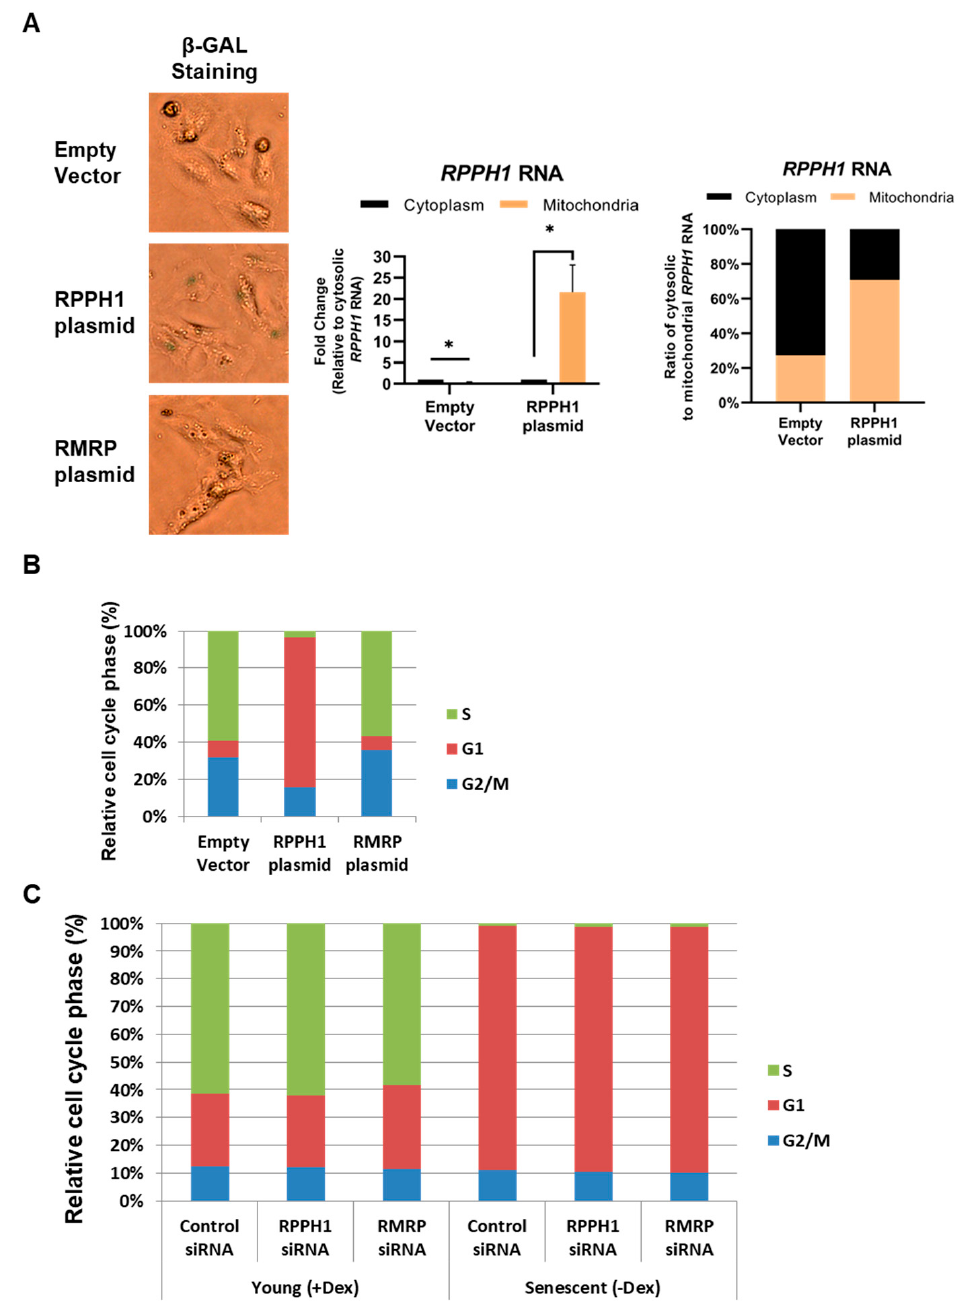
Figure 3. RPPH1 RNA overexpression promotes cellular senescence. ( A ) Acidic β -galactosidase staining (left) after 7 days of Empty Vector, RPPH1, or RMRP plasmid transfection in WI-38 cells. Mitochondrial localization of ectopically expressed RPPH1 RNA was confirmed by RT-qPCR after mitochondrial isolation (middle). Proportion of cytosolic RPPH1 RNA over mitochondrial RPPH1 after transfection of either Empty vector or RPPH1 plasmid (right). ( B ) Proportion of cell division cycle stages after transfection of Empty Vector, RPPH1, or RMRP plasmid. ( C ) Cell cycle analysis of proliferating (+Dex) and senescent ( − Dex) IDH4 cells after transfection of Control, RPPH1, or RMRP siRNA. Data are representative of independent three experiments. Data in ( A ) is average +/ − S.D of independent three experiments. Asterisks denote statistical significance (Student’s t test): * p ≤